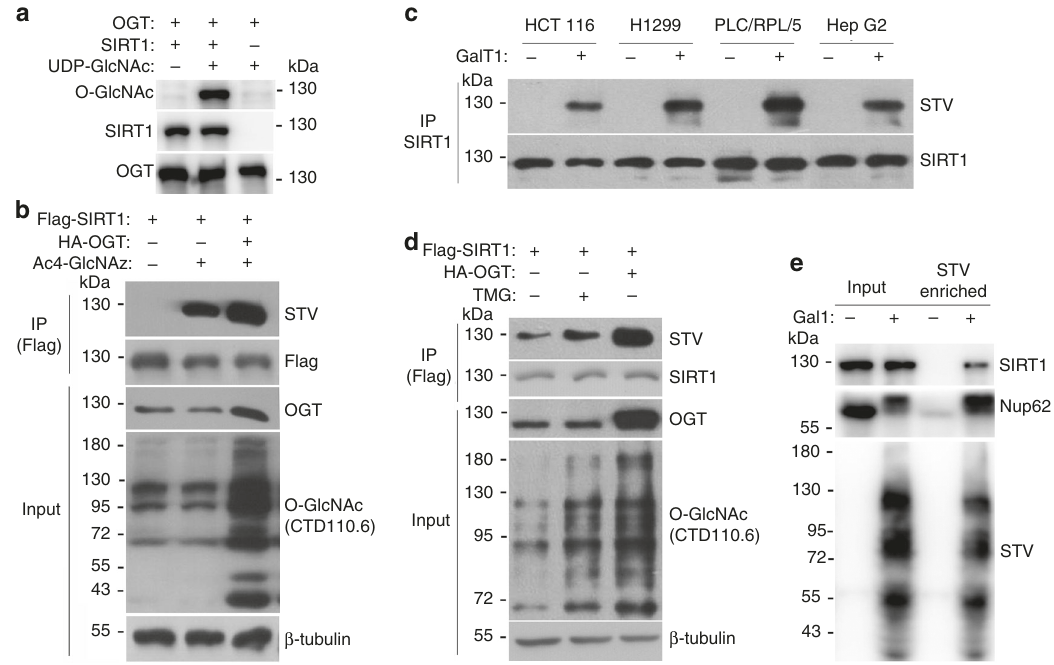
Fig. 2 SIRT1 is O-GlcNAcylated in vitro and in vivo. a O-GlcNAcylation assays using recombinant human SIRT1 and OGT were performed in the presence or absence of UDP-GlcNAc. Reaction mixtures were immunoblotted with antibodies against O-GlcNAc (RL2), SIRT1, and OGT. Data represent two independent experiments. b Plasmids encoding Flag-SIRT1 and HA-OGT were transfected into NCI-H1299 cells, and the O-GlcNAcylation of SIRT1 was detected by either GlcNAz metabolic labeling with a biotin tag and probed with STV-HRP or the indicated antibodies. Data represent three independent experiments. c Detection of O-GlcNAcylated SIRT1 in the indicated cells by chemoenzymatic labeling. Cells were lysed, immunoprecipitated with antibody against SIRT1 and subsequently labeled with GalNAz and biotin, which were then probed with STV-HRP and antibody against SIRT1. Data represent two independent experiments. d Flag-tagged wtSIRT1 with or without HA-OGT was exogenously expressed in NCI-H1299 cells, and the cells were treated with or without 2 μ M TMG for 4 h. Cells were lysed, immunoprecipitated with antibody against Flag-tag and subsequently labeled with GalNAz and biotin, which were then probed with STV-HRP and the indicated antibodies. Data represent three independent experiments. e NCI-H1299 cells, which were pretreated with 2 μ M TMG for 4 h, were lysed and labeled with GalNAz and biotin. And then the biotinylated proteins were enriched and probed with indicated antibodies. Data represent two independent